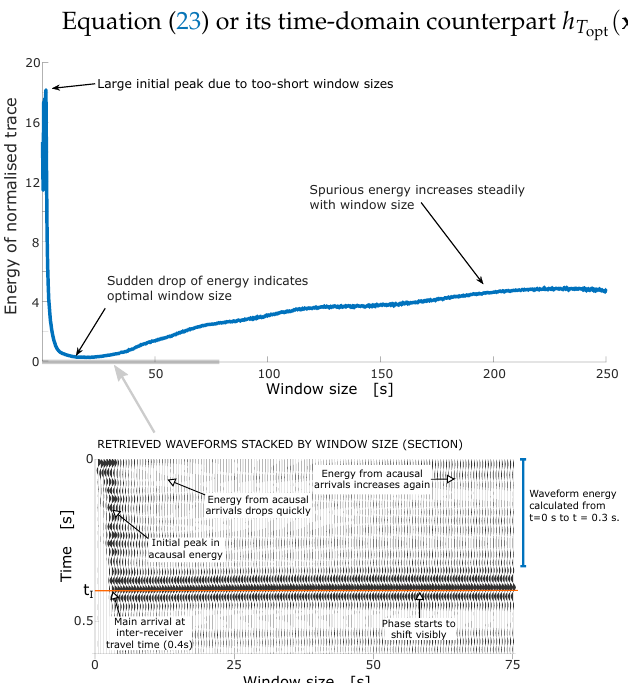
Figure 9. Calculation of acausal energy curve for a recording of a single moving source. Values of T tested ranged between 0.25 s and 250 s. The bottom panel shows the waveforms corresponding to the average random window retrieval for T only in the range between 0.25 s and 75 s, for clarity. The waveforms are arranged by window size T . The arrival of interest is highlighted in orange at time t I = 0.4 s. The top panel shows the acausal energy curve in blue. The waveform energy was calculated for each waveform in the range from t = 0 to t = 0.3 s. The acausal energy curve exhibits a clear initial peak for small values of T , followed by a sharp drop and then a slow increase with T . The minimum is achieved at T opt ≈ 15